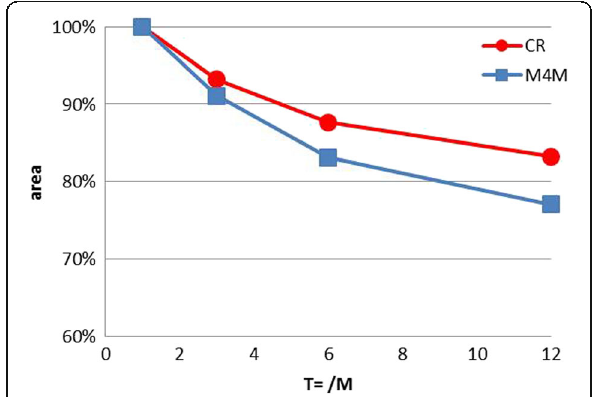
Fig. 6 Access-hole filling surface areas measurement,